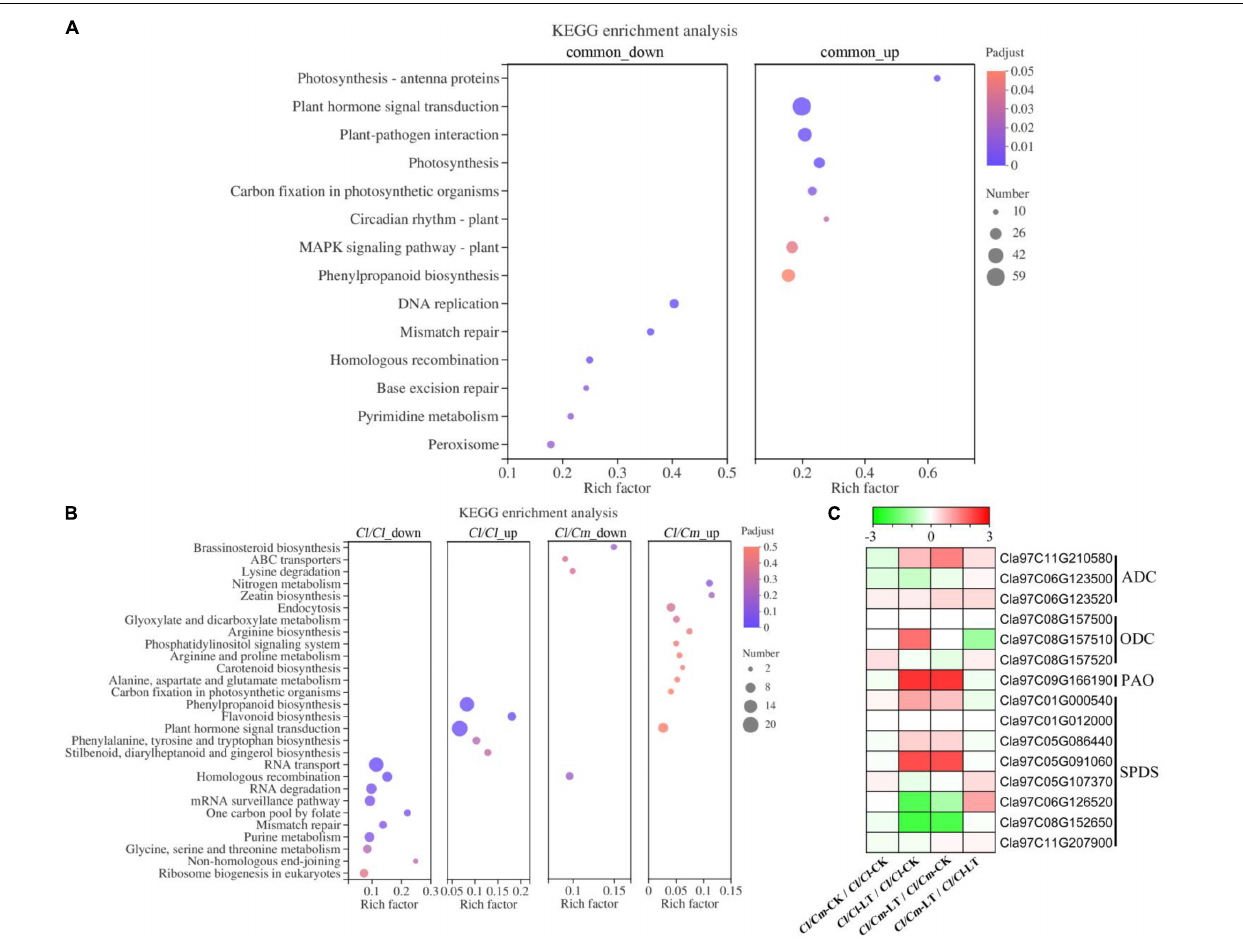
FIGURE 7 | Kyoto encyclopedia of genes and genomes (KEGG) enrichment analysis of DEGs and expression of plant synthesis polyamine-related genes after in Cl/Cl and Cl/Cm plants. (A) Significantly enriched KEGG pathways of common up- and down- regulated genes in response to chilling stress. (B) Significantly enriched KEGG pathways of specific up- and down- regulated genes in self- and pumpkin-grafted watermelon in response to chilling stress. (C) Effects of chilling tolerance pumpkin grafting on synthesis polyamine genes. Dot color and size indicate the Q-value and gene number, respectively, as shown on the right of panels (A,B) . Colors of the boxes represent up-regulated (red) and down-regulated (green) genes. The value is the log 2 fold-change [log 2 (FC)] of each gene ( Panel C)